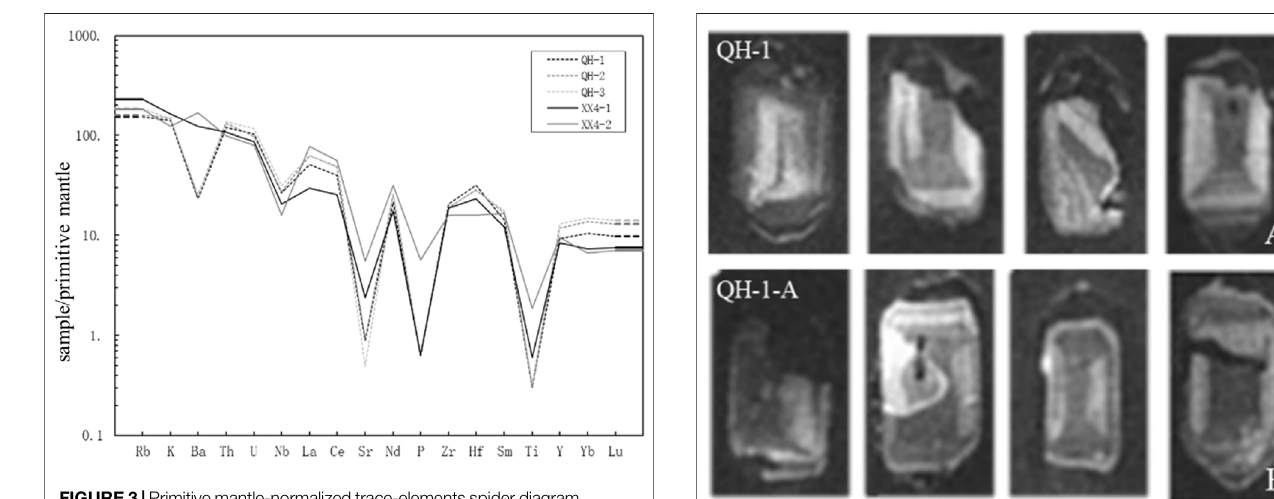
FIGURE3| Primitive mantle-normalized trace-elementsspider diagram.